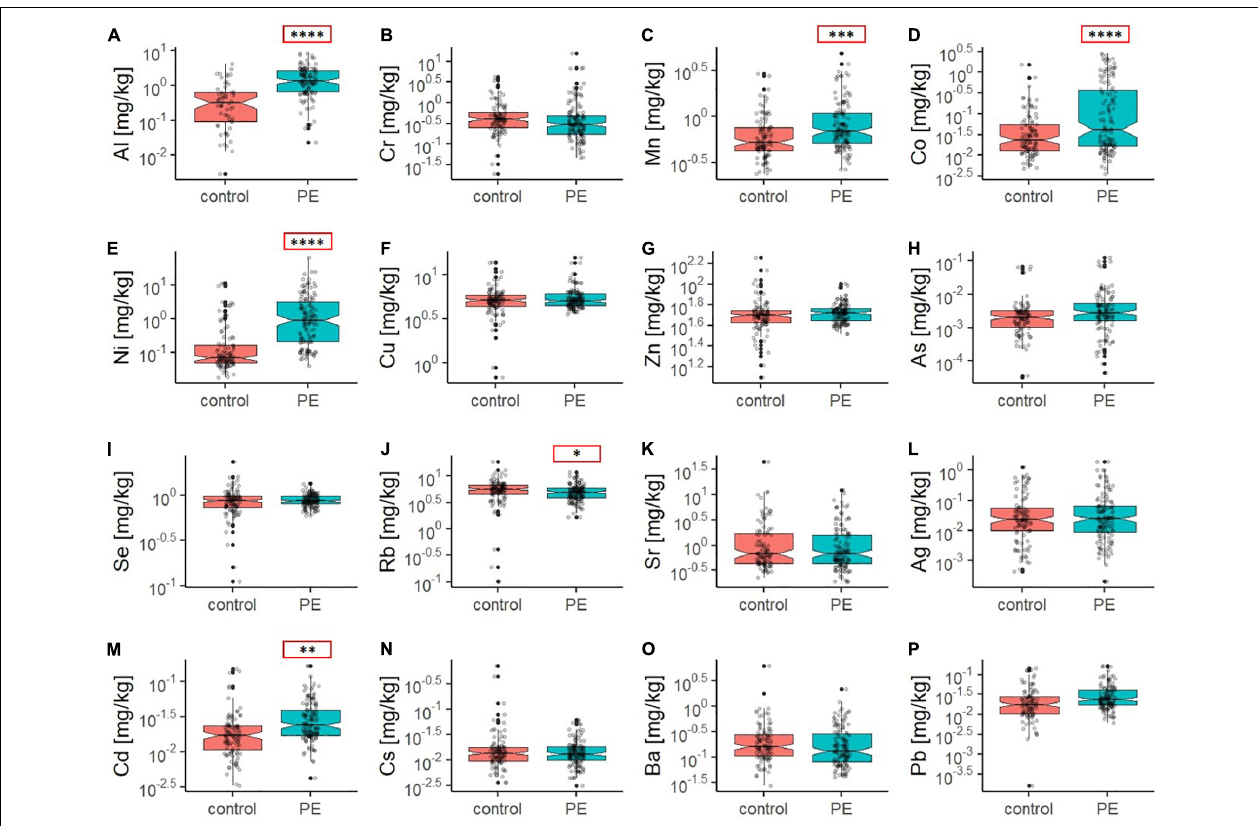
FIGURE 2 | Boxplots (A–P) showing the concentration of trace elements in the placental tissue of the control (red) and PE (green) placenta group as determined by ICP-MS. Outliers are displayed as filled black dots. The entire distribution of data points is shown as gray transparent dots. The black line displays the median and notches the 95% confidence interval of the median. Note that non-overlapping notches strongly suggest a difference in the median. Additionally, asterisks in red boxes indicate significant differences in the mean element concentration between the control and PE group (with ∗ p < 0.05, ∗∗ p < 0.01, ∗∗∗ p < 0.001, and ∗∗∗∗ p < 0.0001, as determined by Welch two sample t -test).